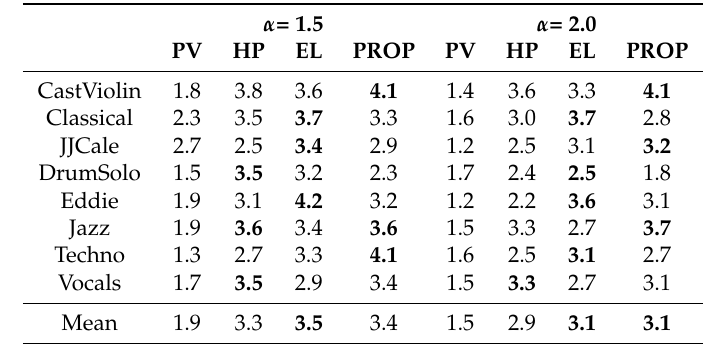
Table 2. Mean opinion scores for the audio samples. PV: phase vocoder; HP: harmonic–percussive separation; EL: élastique algorithm; PROP: proposed method.